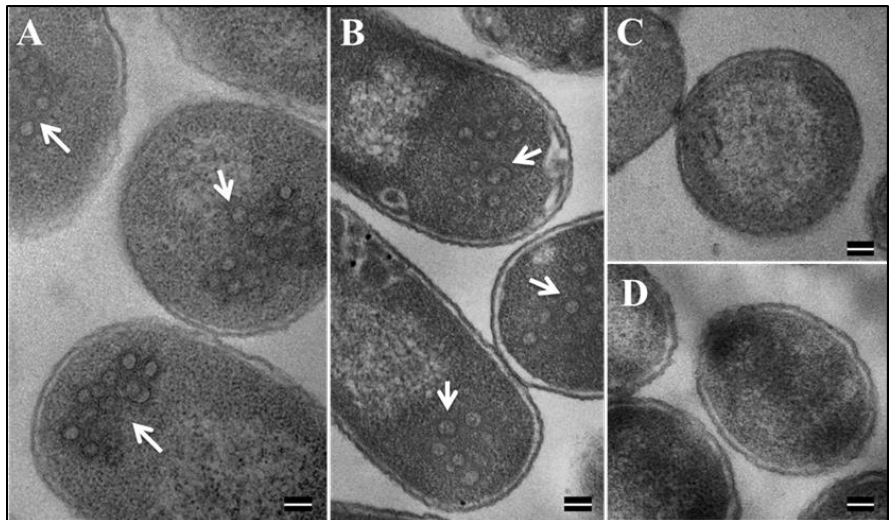
Figure 8. Formation of VLPs by recombinant Pr77 Gag -His 6 -tag fusion in E. coli BL21(DE3). Transmission electron micrographs showing VLPs assembled from ( A ) recombinant Pr77 Gag -His 6 -tag fusion expressed in E. coli BL21(DE3) cells transformed with AK7 and ( B ) AK31 (without His 6 tag); ( C , D ) un-induced BL21(DE3) cells transformed with AK7 and AK31, respectively (Scale bar = 100 nm; 60,000× magnification).